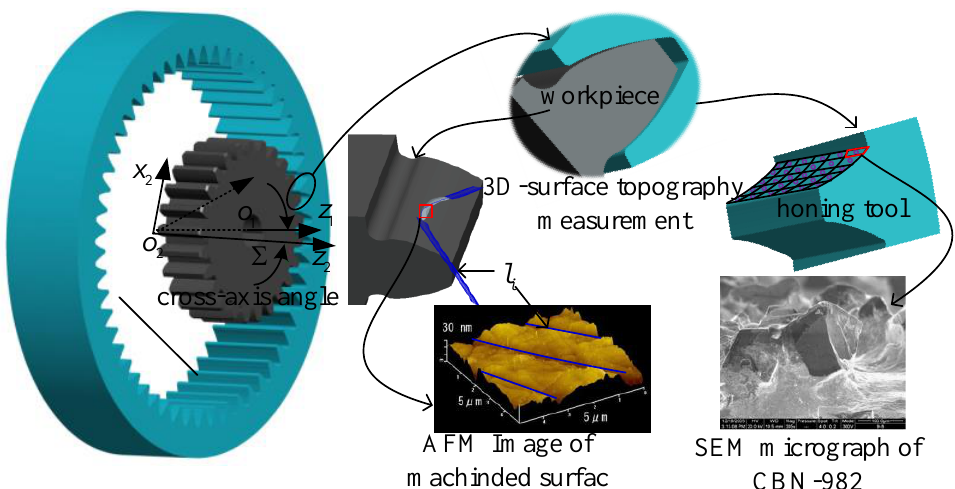
Figure 1. Micromorphology of the honing wheel workpiece tooth surface.